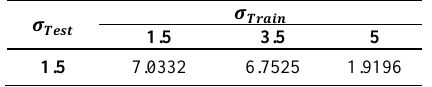
Table 8. MSE of model for PRE test data in noisy condition. Figure 5. Plot of actual and identified outputs for KA in normal